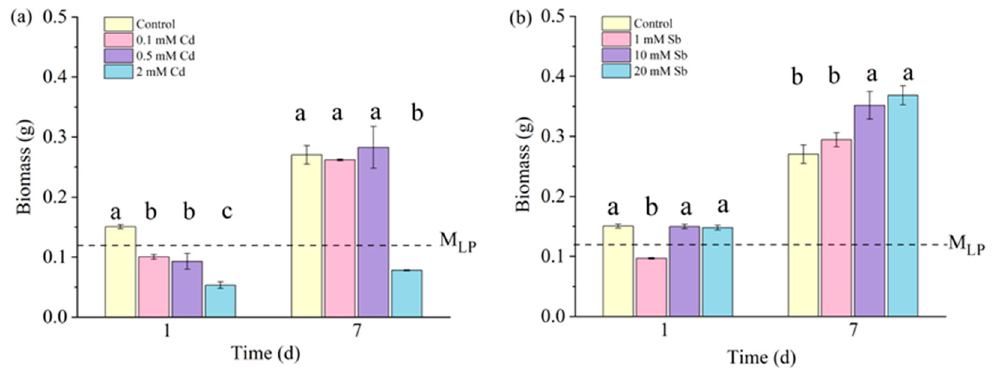
Figure 4. Growth of XK10 under different concentrations of Cd and Sb. ( a ) The biomass of XK10 in different Cd solution; ( b ) The biomass of XK10 in different Sb solution. M LP represented the biomass of XK10 in the logarithmic growth phase. Results are expressed as mean ± SD of three replicates. Different letters indicate significant differences between the same indicators ( p <